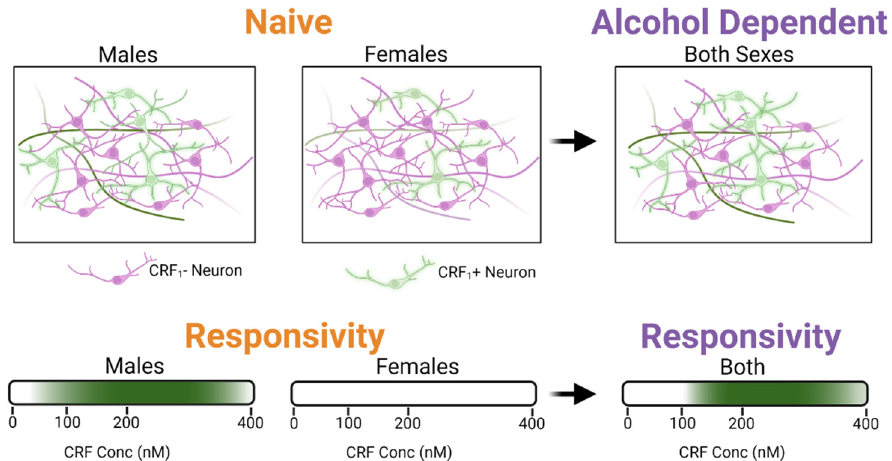
Figure 7. Summary of synaptic changes observed in the central amygdala (CeA) during alcohol dependence in male and female rats. All neurons represented in the top figure are GABAergic. Green denotes CRF 1 + neurons, while purple denotes CRF 1 − neurons. Naïve females have lower CRF 1 expression on GABAergic neurons and are less responsive to corticotropin releasing factor (CRF) than naïve males. In alcohol-dependent females, CRF 1 expressing cell populations and CRF responsivity increase, similar to levels observed in dependent males. Created with